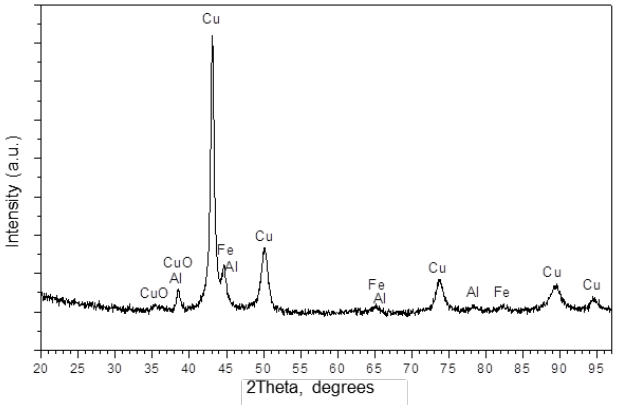
Figure 7. XRD pattern of the 33Al–45Cu–22Fe ((Cu+Fe) + Al) powder milled for 24 min. “Cu”—Cu–Al fcc solid solution; “Fe”— α -Fe bcc variant having a slightly higher lattice constant.